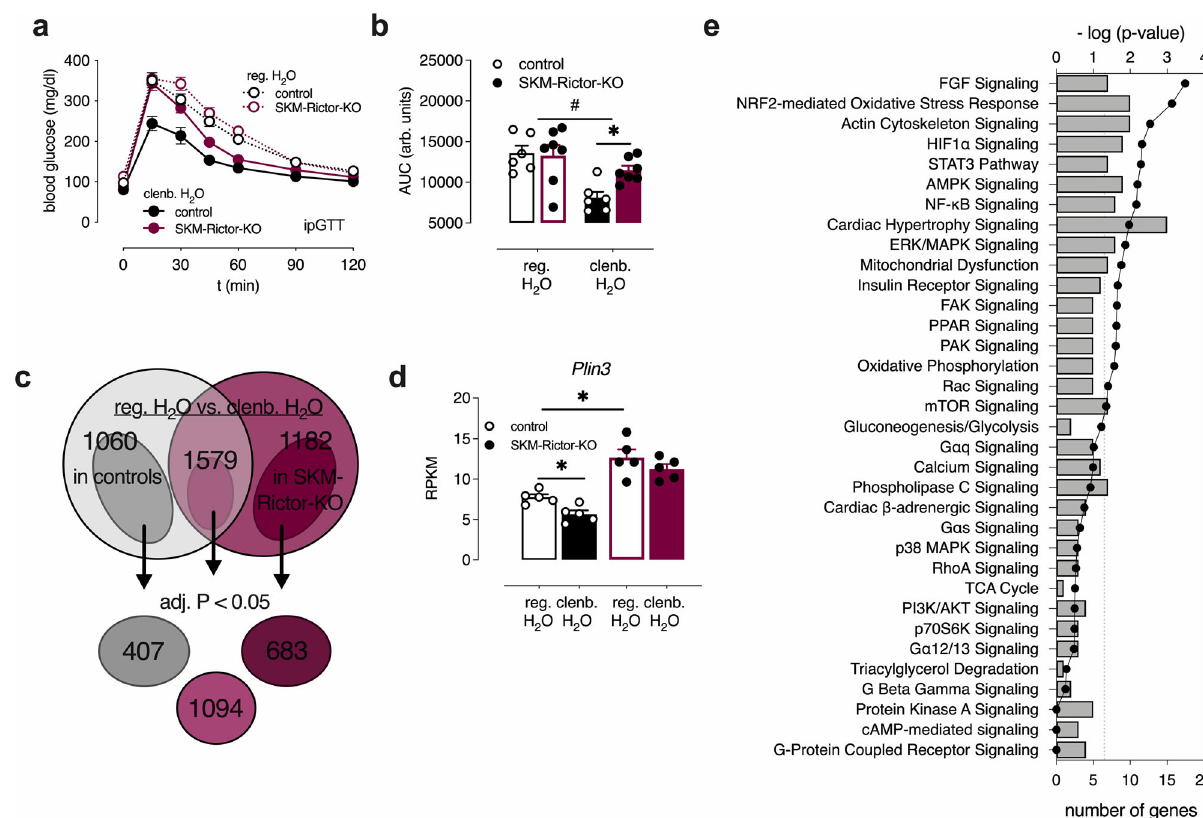
Fig. 5 Chronic clenbuterol treatment causes bene fi cial metabolic effects through SKM mTORC2 signaling. a Glucose tolerance test (GTT) with male lean control ( n = 6) and SKM-Rictor-KO mice ( n = 7, overnight fasted) after consumption of regular drinking water (reg. H 2 O) or clenbuterol-containing drinking water (clenb. H 2 O) for 5 days. b Comparison of Area under the curve (AUC) values for the data shown in a . # p < 0.05 for clenbuterol effect (two- way ANOVA); * p < 0.05 (two-way ANOVA, followed by Sidak ’ s post hoc test), p = 0.06 for clenbuterol × genotype interaction effect (two-way ANOVA). c Intersection of differentially expressed genes in SKM (gastrocnemius muscle) of control vs. SKM-Rictor-KO mice, either maintained on clenbuterol or regular drinking water ( n = 5/group). Adjusted p -value of <0.1 was used for the initial analysis to fi lter out genes that have narrowly missed statistical signi fi cance of the standard adjusted p -value < 0.05. After identifying the differentially expressed genes that were common to both groups (1579 genes) or different in control mice only (1060 genes) or SKM-Rictor-KO only (1182 genes), an adjusted p -value cutoff of 0.05 was applied to these 3 groups. d Plin3 expression levels determined by RNA-Seq analysis. *Signi fi cantly regulated by two-tailed Wald ’ s test (DESeq2) ( n = 5/group, adjusted p -value < 0.05). e Enrichment of signaling pathways of differentially expressed genes in SKM of only control mice maintained on clenbuterol vs. regular drinking water (407 genes from c ), determined via Ingenuity Pathway Analyzer (Qiagen). Data in a , b , and d are presented as means± SEM. Source data are provided as a Source data fi